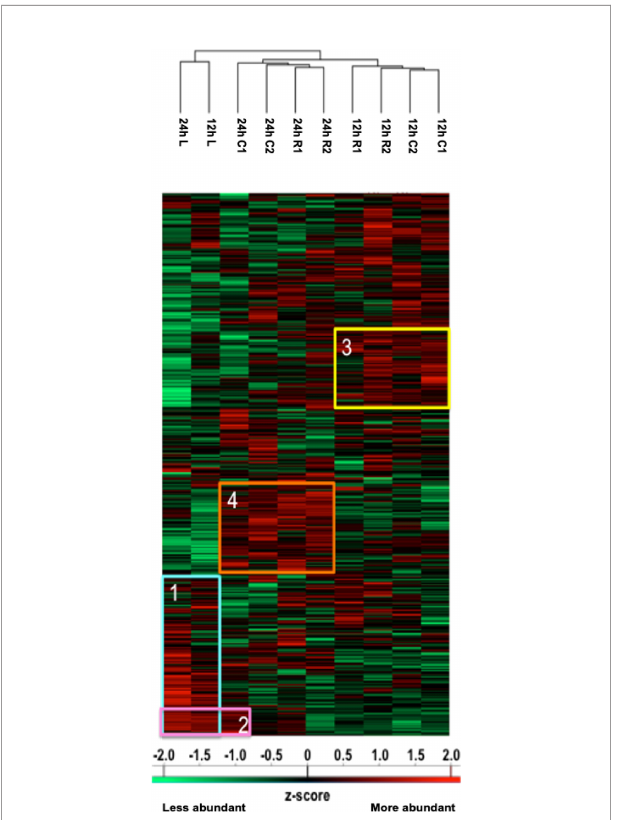
FIGURE 1 | Heatmap illustrating hierarchical clustering obtained after analysis of digested peptides isolated in secretomes from spinal cord segments collected 12 h and 24 h after SCI. Four clusters are highlighted. Cluster 1 corresponds to the in fl ammatory proteins ’ accumulation in lesions. Cluster 2 demonstrates that the proteomic pro fi le of C1 starts to cluster with lesions after 24 h. Clusters 3 and 4, respectively, represent proteins more abundant in other segments at 12 h (neurite outgrowth inhibition) and at 24 h (synaptogenesis and neurogenesis